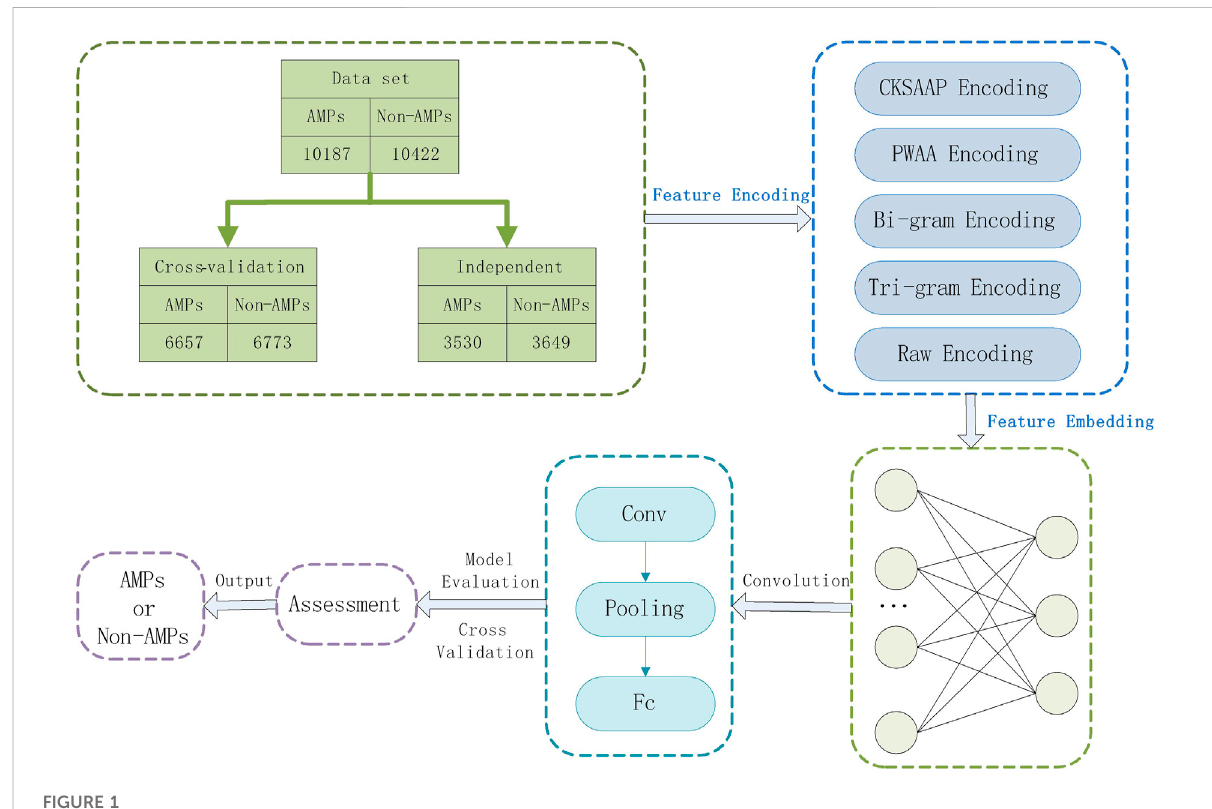
FIGURE 1 The work fl